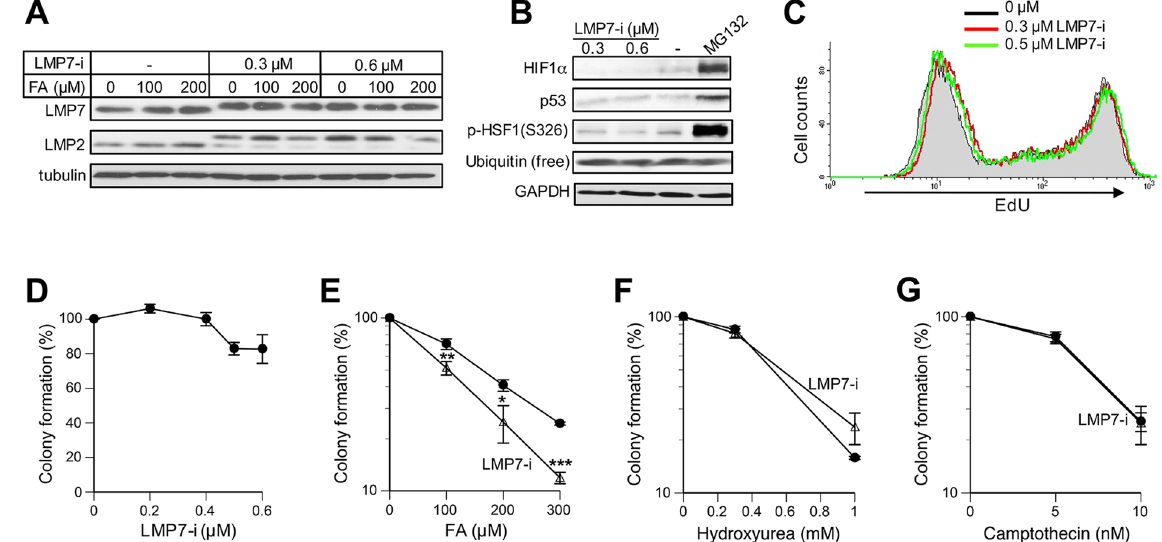
Figure 2. Cytotoxicity of FA and replication stressors in H460 cells. ( A ) Westerns for LMP2 and LMP7 in cells treated with FA and ONX-0914 (LMP7-i) for 3 h. ( B ) Westerns for cells treated with LMP7-i and MG132 (5 μ M) for 4 h. ( C ) FACS profiles of EdU incorporation in cells treated with LMP7-i for 6 h. EdU was added during the last hour. ( D ) Clonogenic survival of cells treated with LMP7-i for 24 h. ( E ) Clonogenic survival of cells cotreated with FA and 0.5 μ M LMP7-i for 3 h and then incubated for 24 h with 0.5 μ M LMP7-i (means ± SD for three experiments in triplicates, * p < 0.05, ** p < 0.01, *** p < 0.001). ( F ) Clonogenic survival of cells cotreated for 24 h with 0.5 μ M LMP7-i and hydroxyurea or ( F ) camptothecin (means ± SD for two experiments in triplicates).